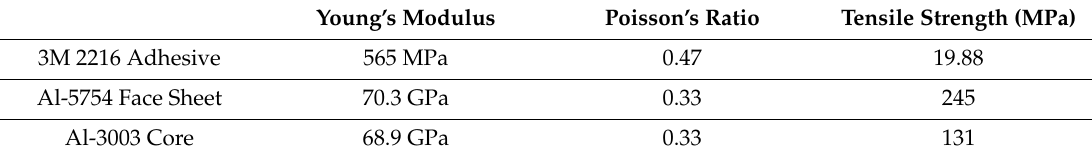
Table 2. Mechanical properties of the adhesive, and the Al-5754 and Al-3003 alloys.